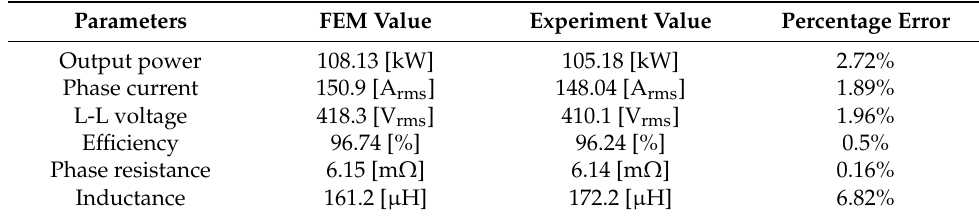
Table 4. Comparison of Inconel 718 Shaft Material FEM and Experiment Results.